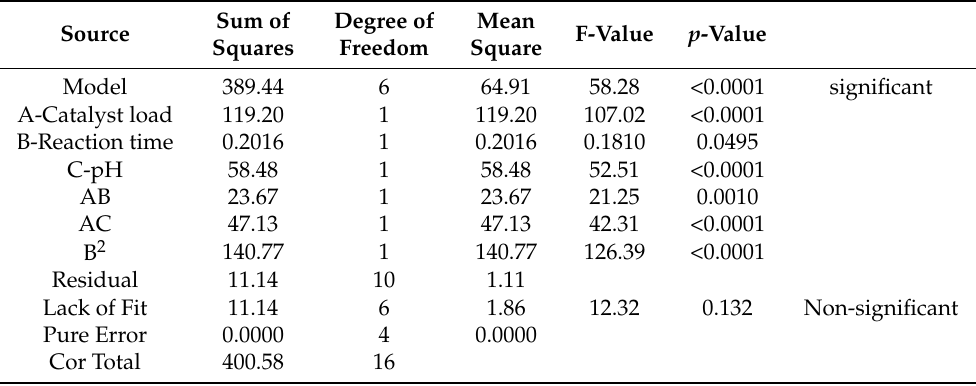
Table 4. Analysis of variance (ANOVA) results for color quadratic models.